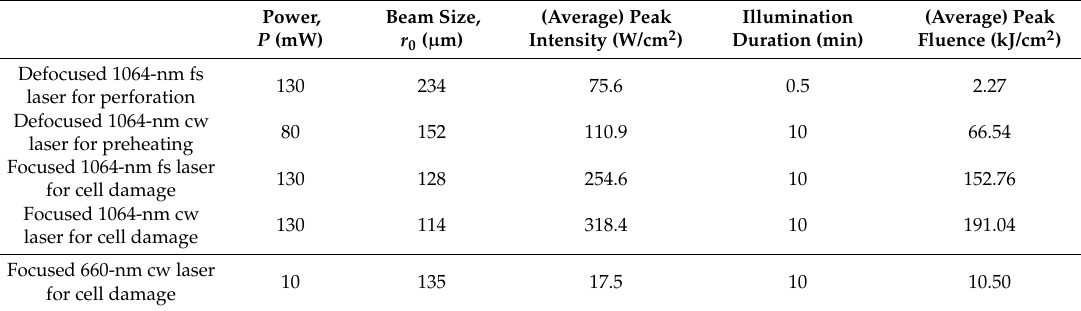
Table 1. Laser conditions for generating the cell perforation, preheating, and damage effects. For the fs laser, the time-average values are